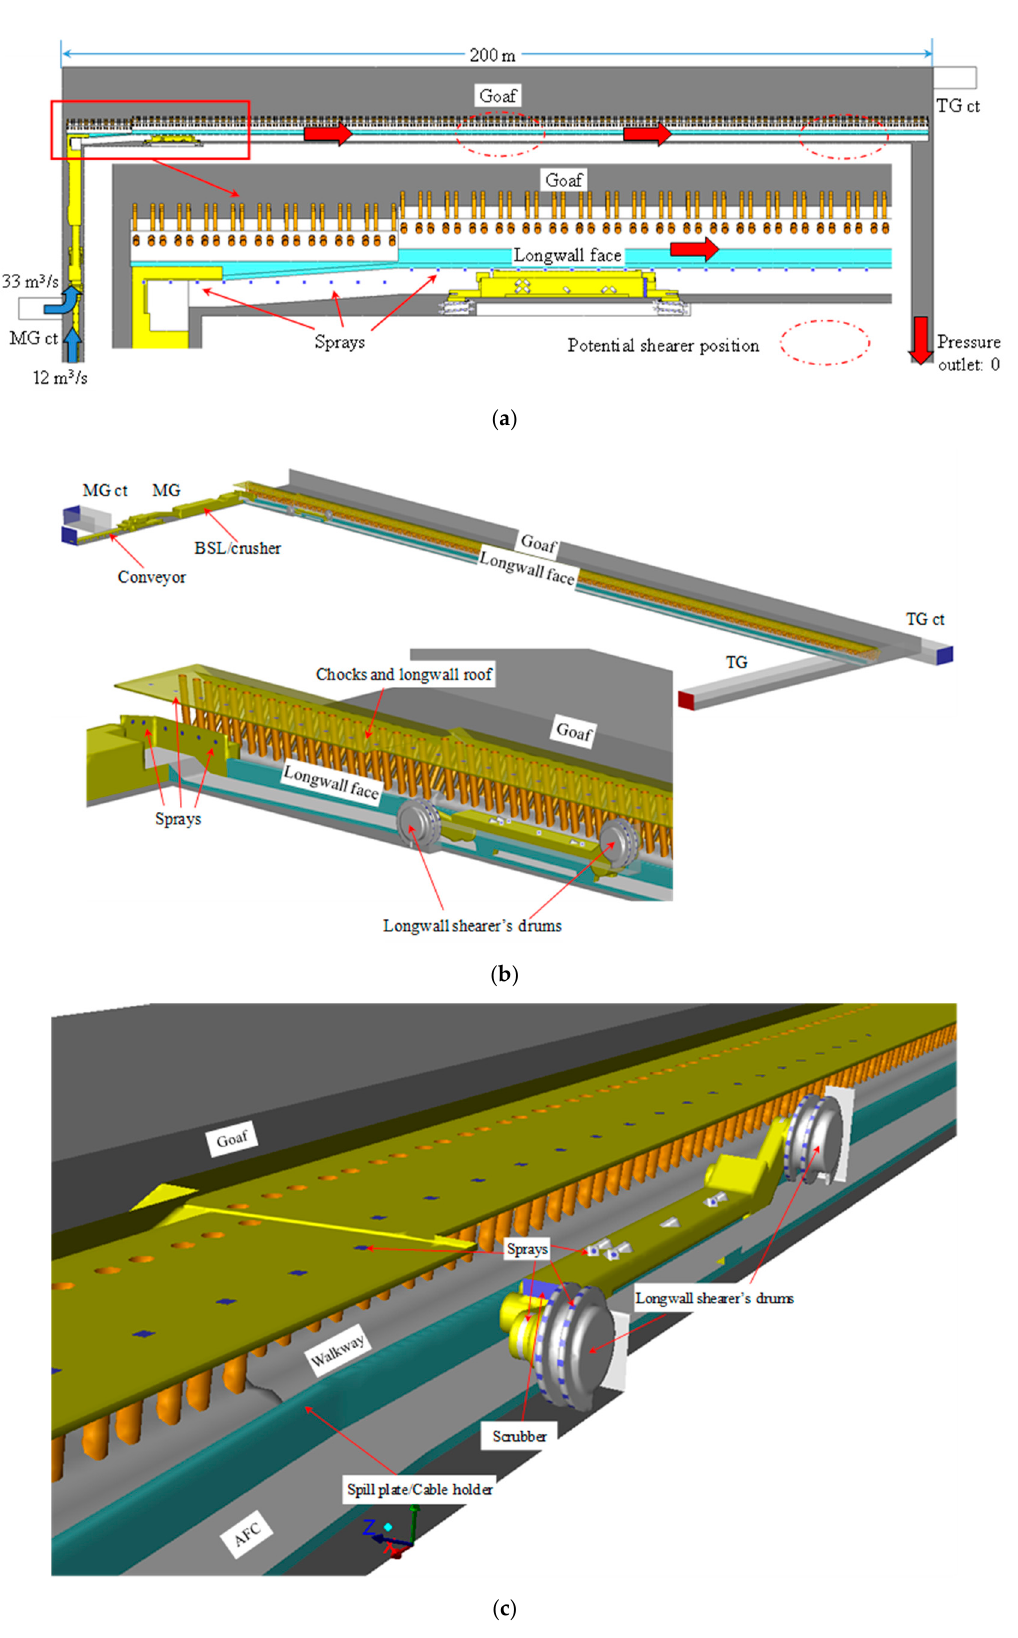
Figure 2. Longwall model layout when shearer cuts towards TG: ( a ) Plan view of the longwall model (ct: cut through); ( b ) 3D view of the longwall model (ct: cut through); ( c ) Closer view around the shearer.